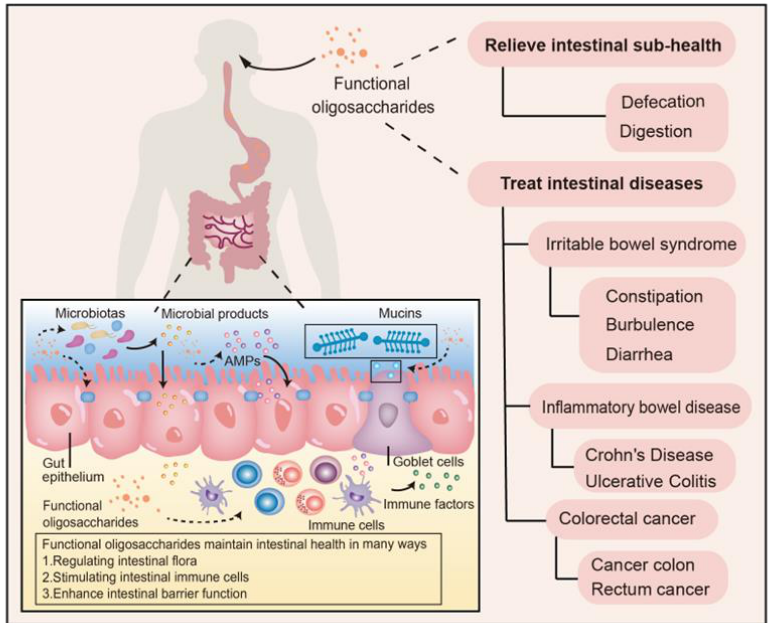
Figure 1. Schematic overview of the effects of functional oligosaccharides on intestinal barrier function and health. AMPs: antimicrobial